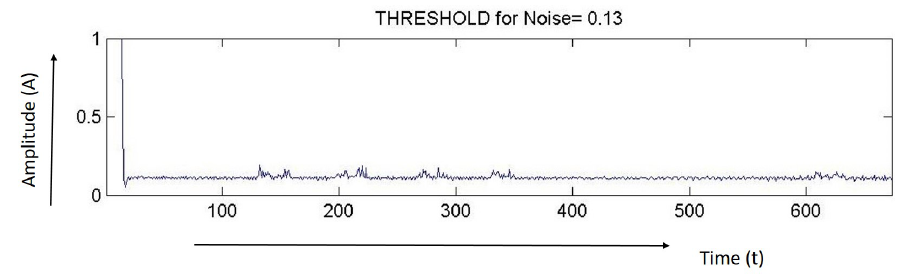
Figure 4. Noise level.